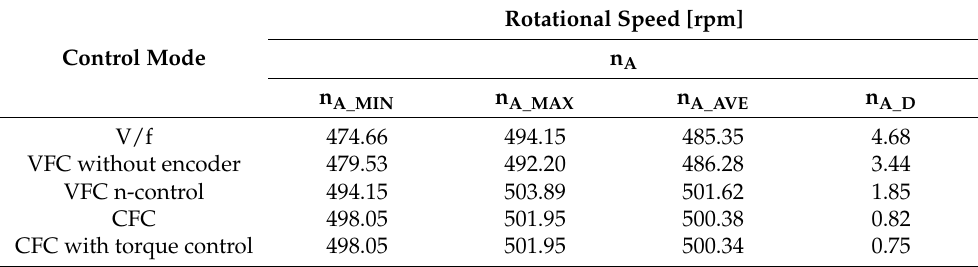
Control Mode Table 15. Characteristics of the rotational speed n A in the steady state (with the external load).